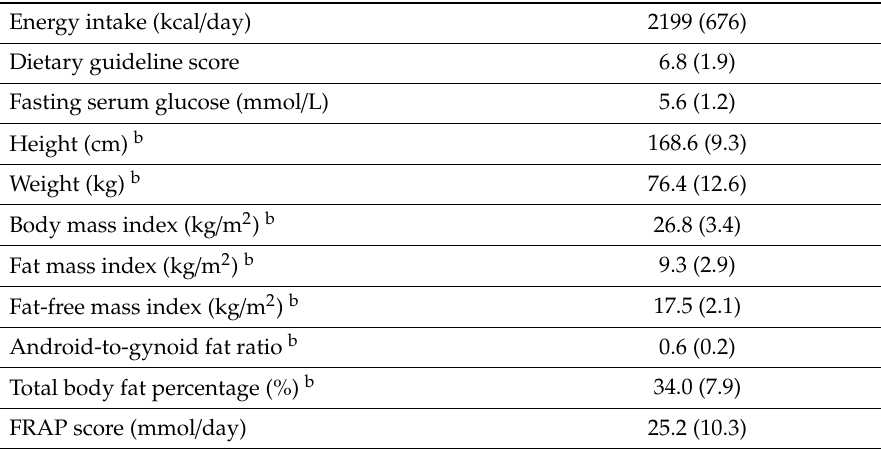
Table 2. Longitudinal associations between Ferric Reducing Ability of Plasma (FRAP) score and fat